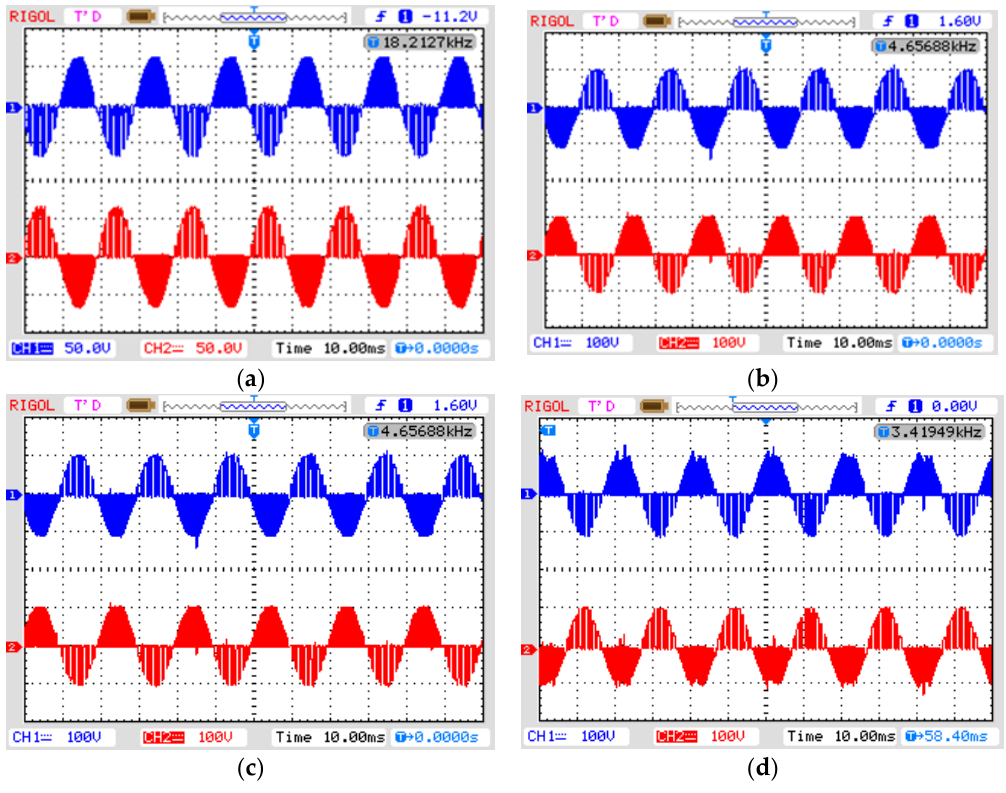
Figure 11. Voltage stresses across ( a ) M 2 ( D S 2 ); ( b ) M 3 ( D S 3 ); ( c ) M 5 ( D S 5 ); ( d ) M 6 ( D S 6 ).